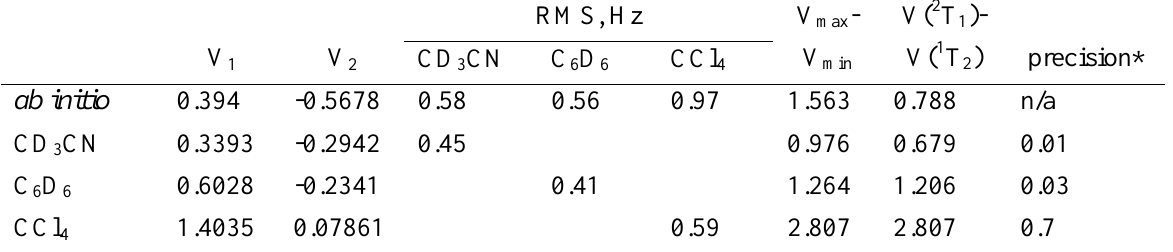
Table 5. Results of pseudorotational potential optimization for trans-1,2-dichlorocyclopentane.